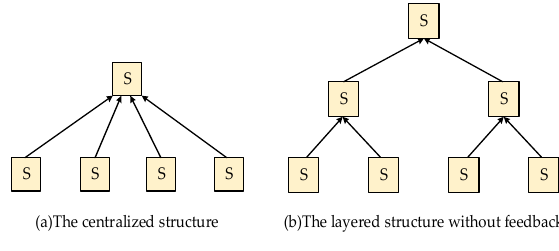
Figure 3. Single-connected fusion structures.